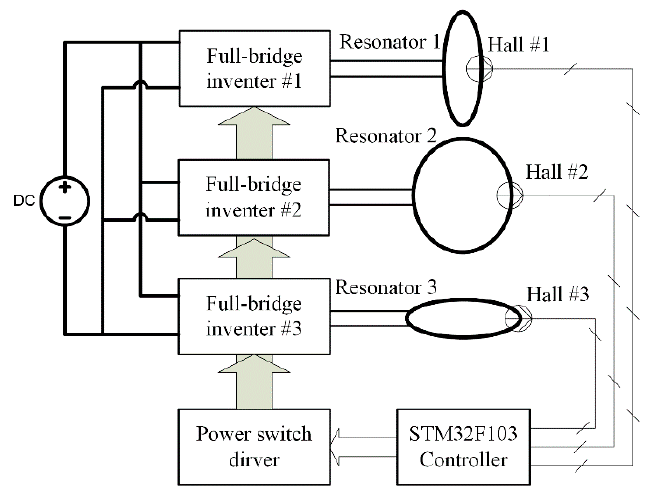
Figure 5. Schematic of the experimental setup.